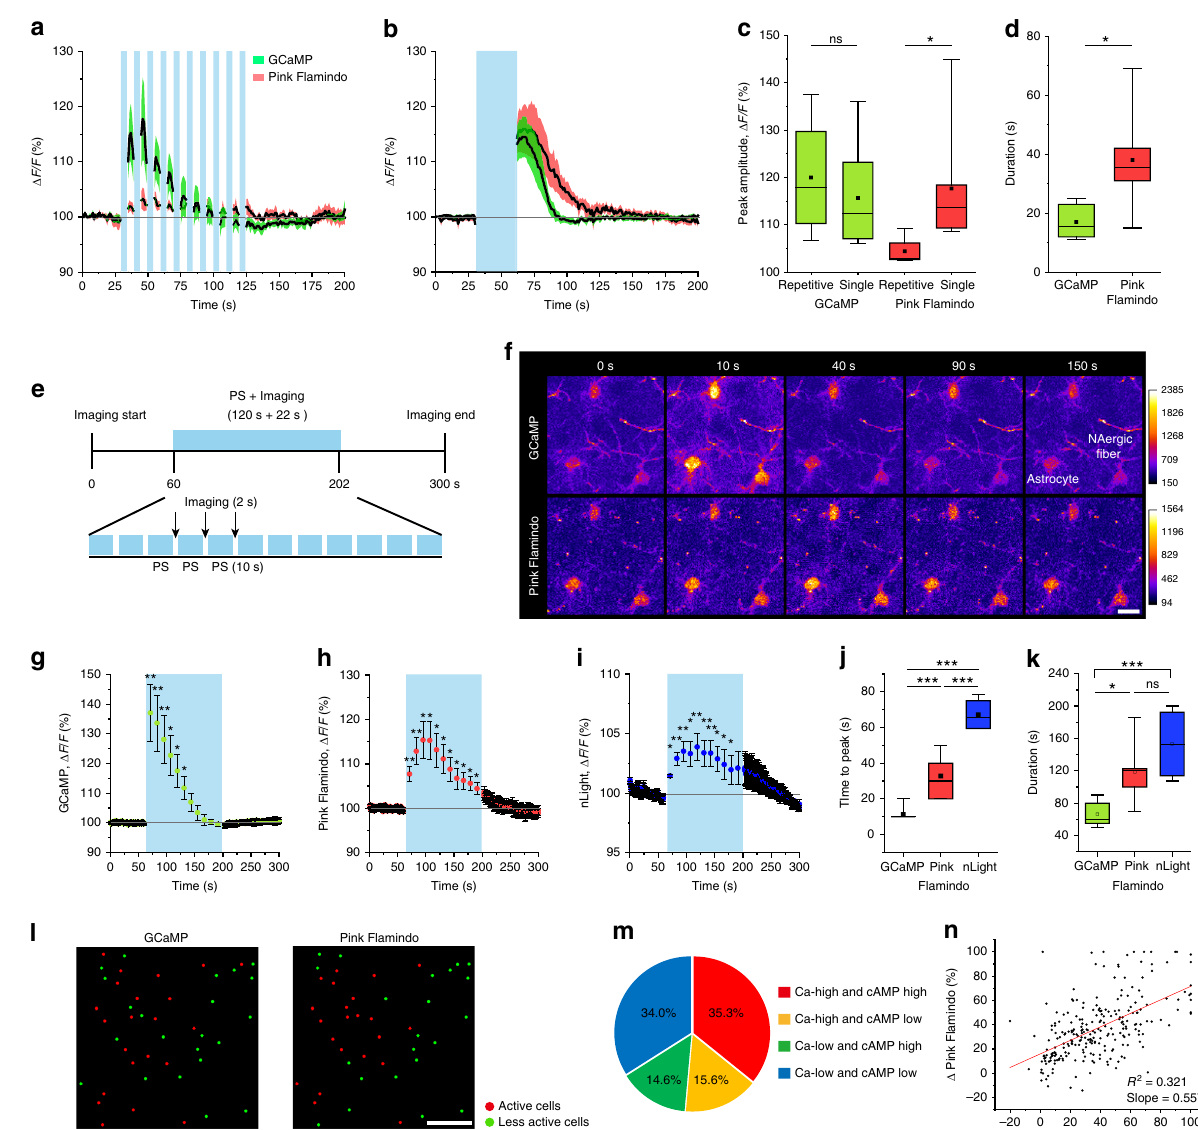
Fig. 3 Distinct dynamics of astrocytic Ca 2 + and cAMP. a – d Simultaneous imaging of GCaMP and Pink Flamindo with repetitive [3 s × 10, 7 s inter-stimulus interval] ( a ) and continuous [30 s] ( b ) PS. The peak amplitude of Pink Flamindo differs substantially between the two PS paradigms, whereas GCaMP shows similar peak amplitudes ( n = 4 – 7 sessions, 4 – 6 mice) ( c ). Durations of astrocytic Ca 2 + and cAMP responses to 30-s PS are distinct ( d ) ( n = 6 sessions, 4 mice). e – k 120-s PS of NAergic fi bers. The long-time stimulation of NAergic fi bers consists of 10-s PS and 2-s imaging that repeats 12 times ( e ). GCaMP signals show faster response and shorter duration ( f , g ), and Pink Flamindo signals exhibit slower increase and long-lasting duration ( f , h ). The dynamics of extracellular NA similarly long with that of astrocytic cAMP ( i ). Quanti fi cation of time to peak ( j , n = 4 – 8 sessions, 4 – 6 mice) and duration ( k , n = 4 – 8 sessions, 4 – 6 mice). Scale bar: 20 μ m. l – n GCaMP and Pink Flamindo responses classi fi ed into active cells and less active cells ( l ). Red and green circles indicate active and less active cells, respectively. Combinatorial classi fi cation of GCaMP and Pink Flamindo responsiveness ( m ). Correlation of GCaMP signal changes and Pink Flamindo signal changes ( n , n = 249 cells, 7 mice, Pearson correlation; R 2 = 0.32, slope = 0.557). Scale bar: 100 μ m. Analysis was performed from average of individual sessions in a – k . l – n were analyzed from individual cell responses. Box plots: box range, 25 – 50 – 75% quatile; square, mean; whiskers, max – min. Student ’ s t -test with Welch ’ s correction: c , d ; one-way ANOVA with Turkey ’ s test: c ; paired t -test: j , k ; * p < 0.05, ** p < 0.01, *** p <